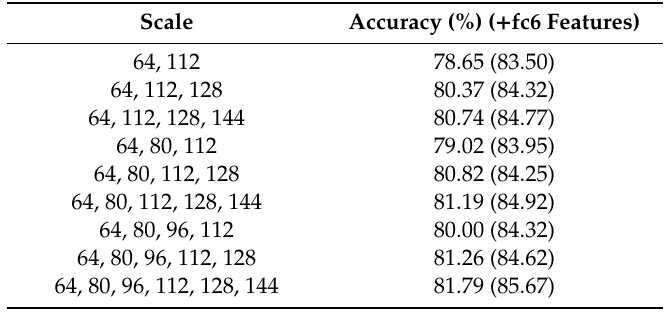
Table 6. Performance of di ff erent scales on MIT indoor 67